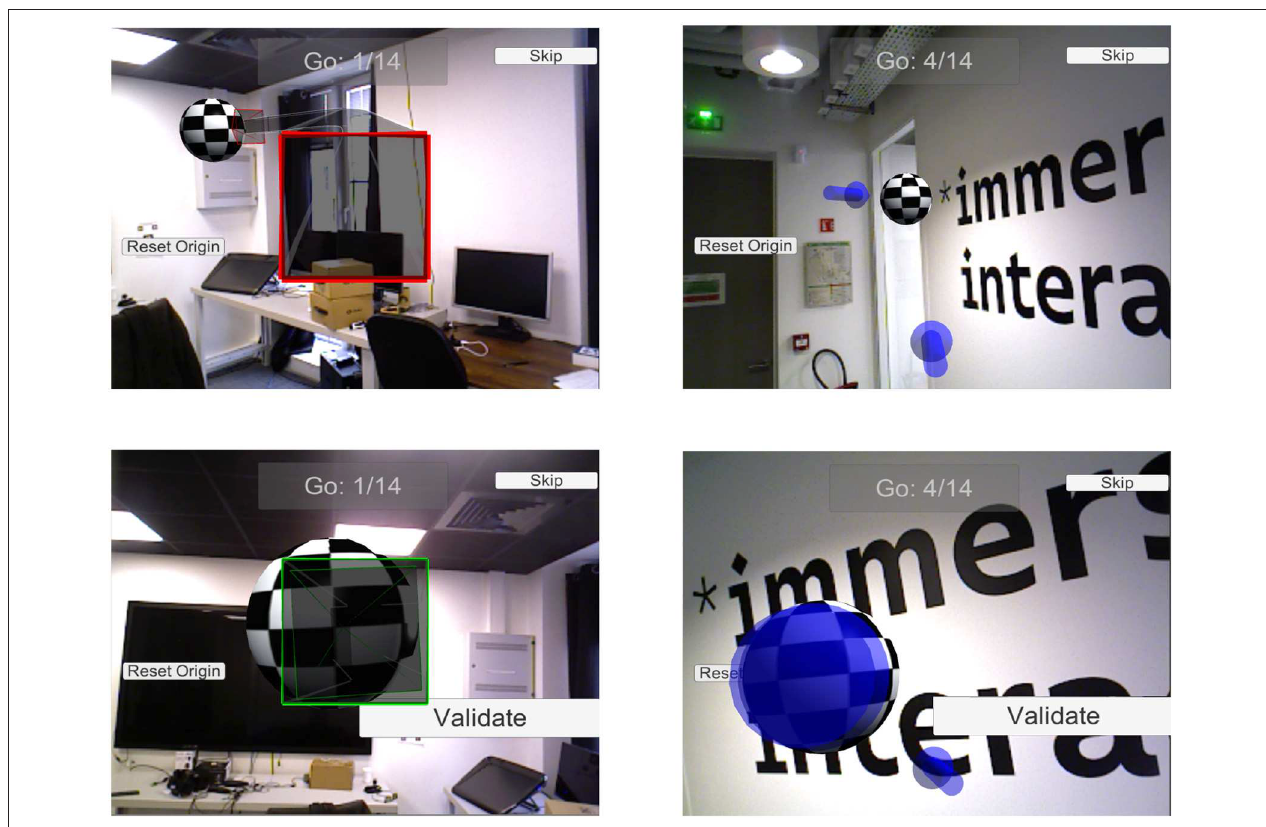
FIGURE 15 | The two guiding techniques compared in this study. The squared guiding pointer is shown on the left, and the pointer with compass on the right (the compass is the small cylindrical pointer at the bottom of the viewport). The checkered sphere is the target on which subjects must reach a specific PoV. In the lower images, the user reaches the designated target and the PoV is sufficiently aligned with the desired PoV to validate the final